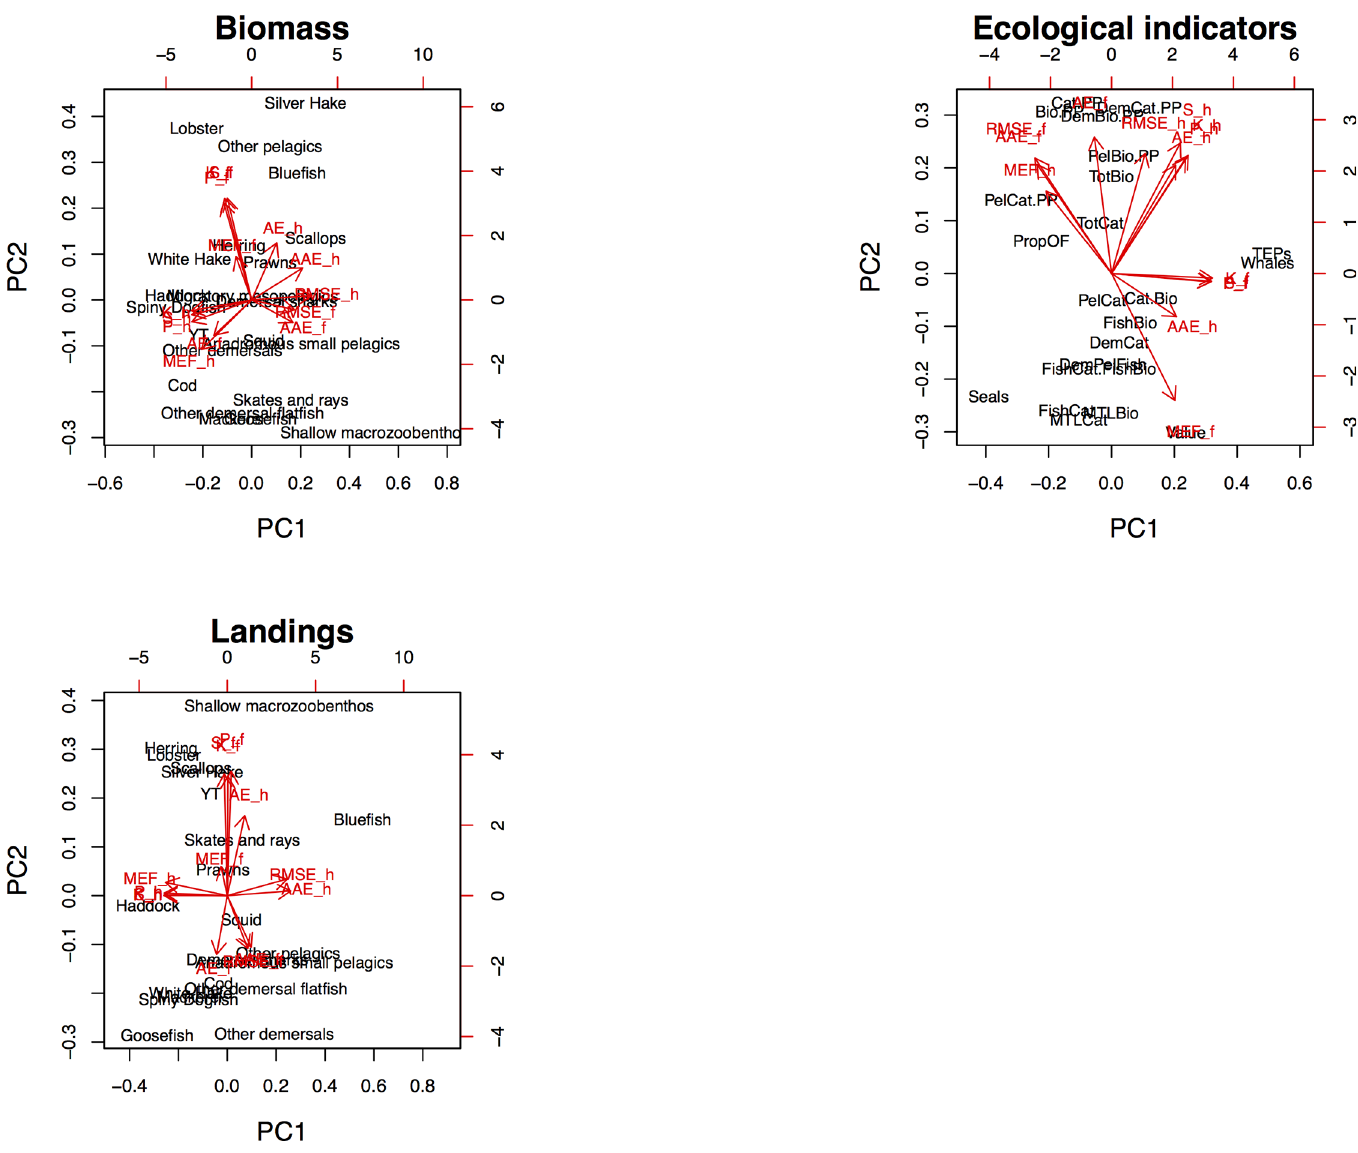
Fig 7. Principal component (PCA) biplot of loadings and score of the 1 st and 2 nd principal component from a PCA analysis of the different skill metrics: MEF, AE, AAE, RMSE, Pearson Correlation (P), Kendall Rank Correlation (K) and Spearman Rank Correlation(S), calculated for the hindcast (_h) and forecast (_f) for the time-series for biomass, landings and ecological indicators. Loadings for the skill metrics are shown in red while scores for the species, catches and indicators are in